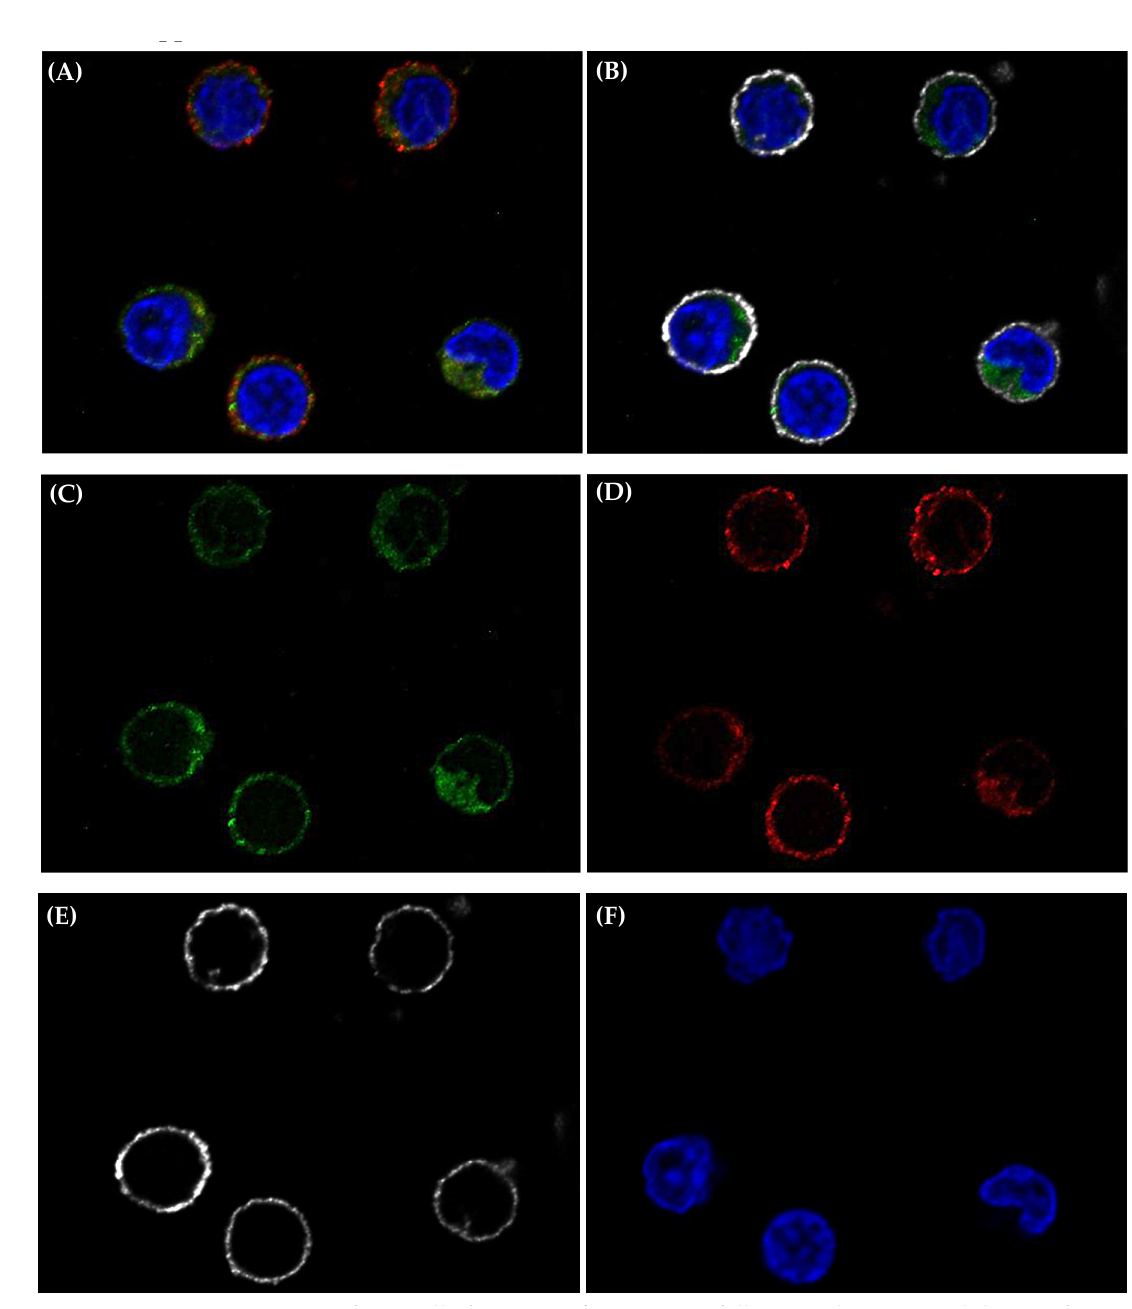
Figure A5. Representative composite images of NK cells from a ME/CFS patient following pharmacomodulation of TRPM7. Co-localisation of TRPM7 (green) with ( A ) PIP 2 (red) and ( B ) actin (white) with the nucleus in blue. Individual images of ( C ) TRPM7, ( D ) PIP 2 ( E ) actin ( F ) nucleus also presented. Abbreviations: natural killer (NK), transient receptor potential melastatin 7 (TRPM7), phosphatidylinositol 4,5-bisphosphate (PIP 2 ).